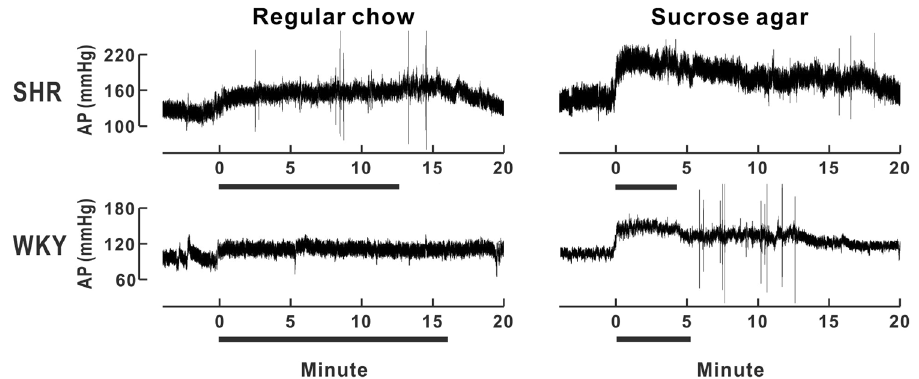
Figure 1. Representative recordings of arterial pressure (AP) from spontaneously hypertensive rats (SHR) and Wistar Kyoto rats (WKY) before, during and after eating either regular chow or sucrose agar. Time zero indicates the time of the rat’s first bite of either the regular chow or sucrose agar and the horizontal lines indicate the duration of food